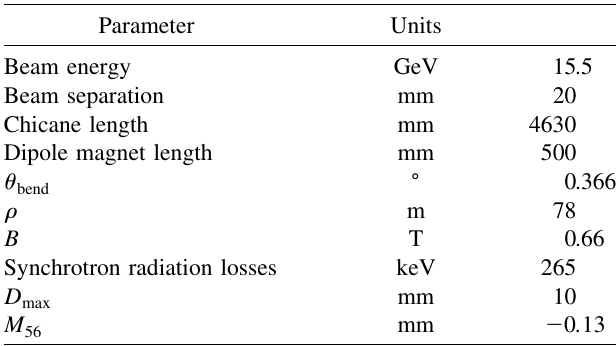
TABLE II. Parameters of the bypass chicane for 15.5 GeV.